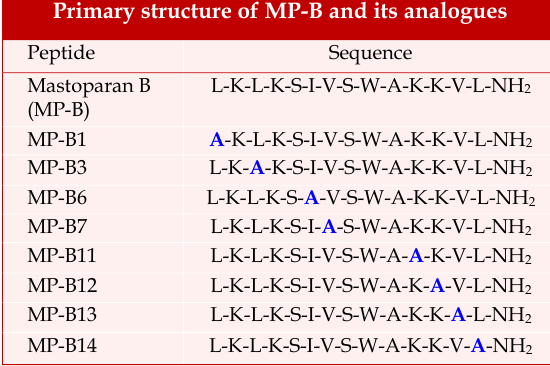
Primary structure of MP-B and its analogues Peptide